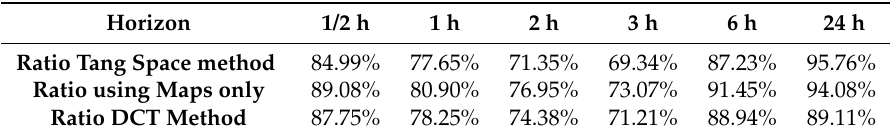
Table 3. Improvement Ratio of the RMSE between tangent space forecast and frozen maps when using the tangent space forecaster vs. the case of not using the tangent space of each of the maps. Horizon 1/2 h 1